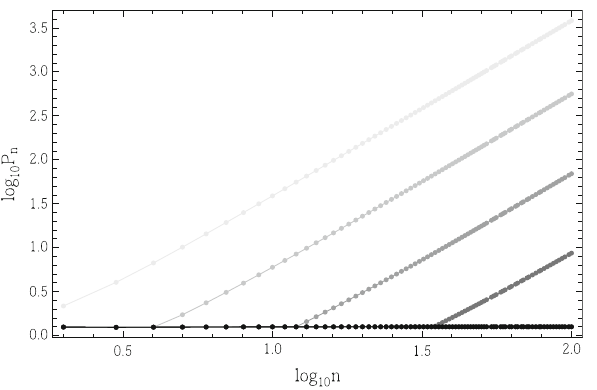
Fig. 7 The time evolution of power spectrum in the case of ˜ m = 2 H 0 , √ H 0 = 8 π/ 3. The darker curves correspond to the spectra at later times. The lightest curve is the initial Lorentzian spectrum at time t i . For each n mode, the power is evaluated up to its horizon crossing